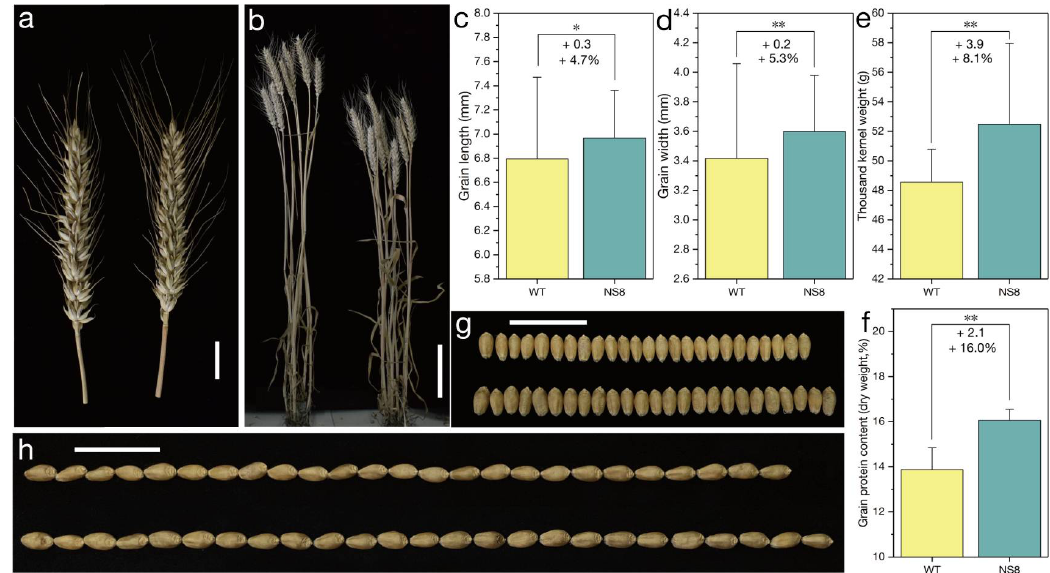
Figure 5. Phenotype of the mutant NS 8 during the 2020–2021 growing season. ( a ) Spikes of the wild-type (WT) ( left ) and NS 8 ( right ) plants. Scale bar, 2 cm. ( b ) WT ( left ) and NS 8 ( right ) plants. Scale bar, 10 cm. Comparisons of the grain length ( c ), grain width ( d ), thousand kernel weight ( e ), and grain protein contents ( f ) of the WT and NS 8 samples. **, p < 0.01; *, p < 0.05. Data are presented as the mean ± standard deviation. ‘+’ indicates more than the WT control. ‘+0.3 (cid:48) in panel ( c ) indicates the NS 8 grain was 0.3 mm longer than the WT grain (on average). ‘+4.7%’ in panel ( c ) indicates that Q c1 -N8 increased the grain length by 4.7% (on average). ( g ) Kernel width of the WT ( upper ) and NS 8 ( lower ) samples. Scale bar, 2 cm. ( h ) Kernel length of the WT ( upper ) and NS 8 ( lower ) samples. Scale bar, 2